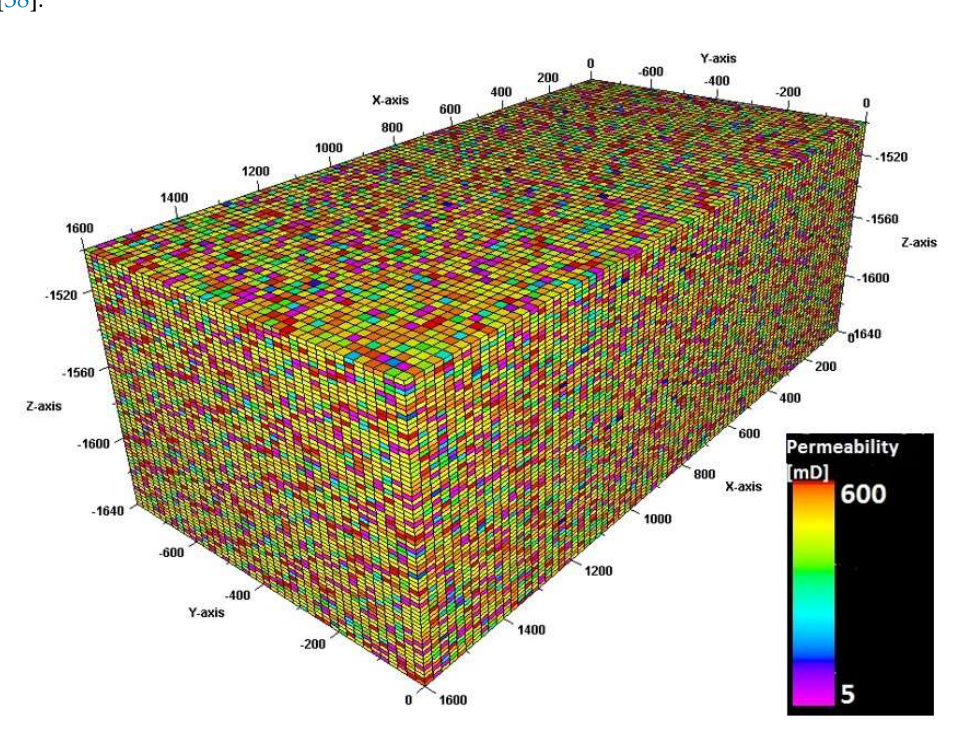
Table 1. Input data for the basic model [22].